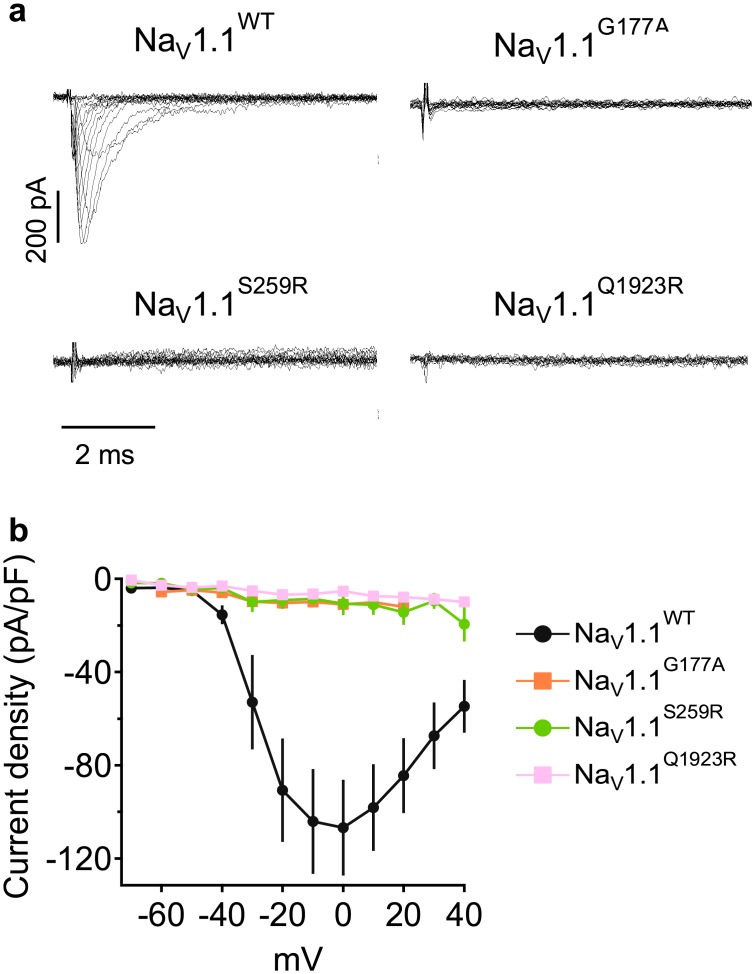
Complete loss of function in missense SCN1A mutations.(A) Representative set of sodium current traces from HEK-293 cells expressing NaV1.1WT, NaV1.1G177A, NaV1.1S259R or NaV1.1Q1923R. (B) Mean current-voltage (I-V) relationships of sodium current densities. NaV1.1WT n = 31; NaV1.1G177A n = 10; NaV1.1S259R n = 7; NaV1.1Q1923R n = 7.